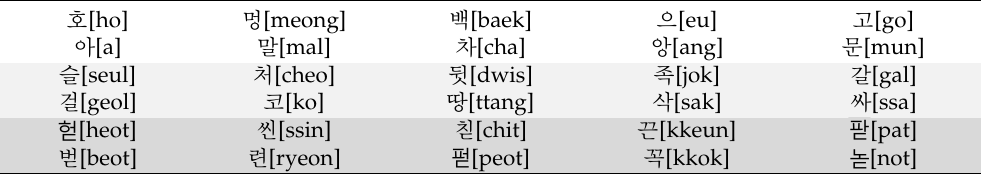
Table 9. Example of CVC syllable lists (in Korean).